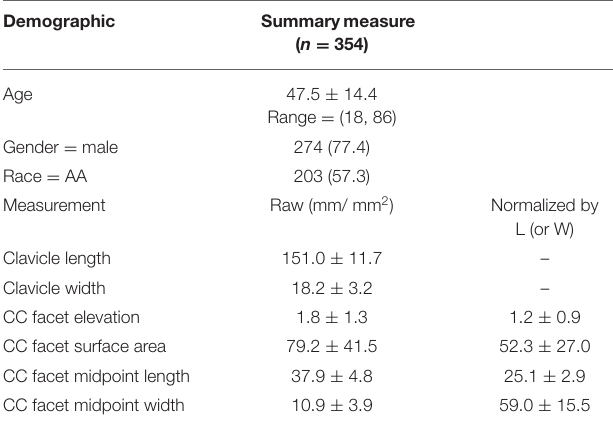
measures for demographics and morphological characteristics and measurements for all observable facets. The normalized CC facet midpoint along clavicle width (anterior to posterior) using the anterior border of the clavicle as the reference point ( Table 4 ) was significantly different between males (60.4 ± 14.8) and females (54.4 ± 16.8, p = 0.017), but not with respect to age or race. CC facet position along the width of the clavicle varied in all groups (range 10–90%), but was located consistently more posteriorly in males. With regard to CC facet midpoint